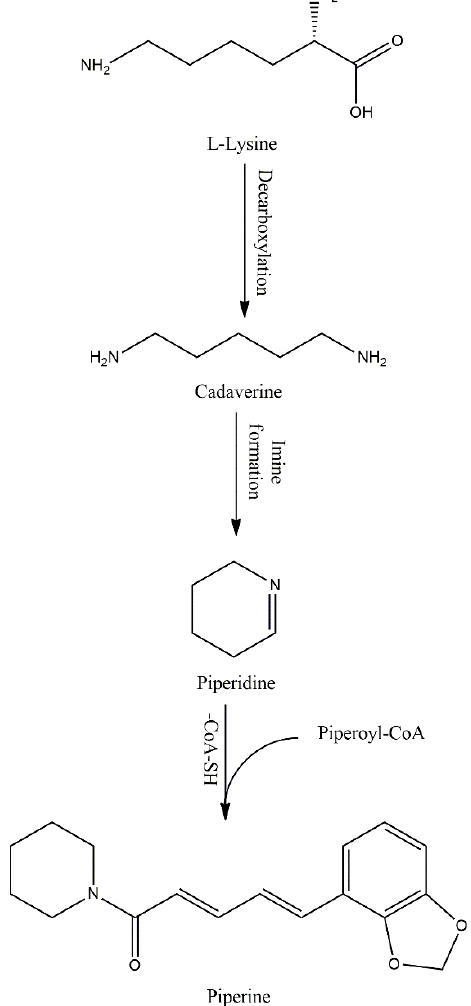
Figure 1. Possible biosynthesis pathway of PIP.